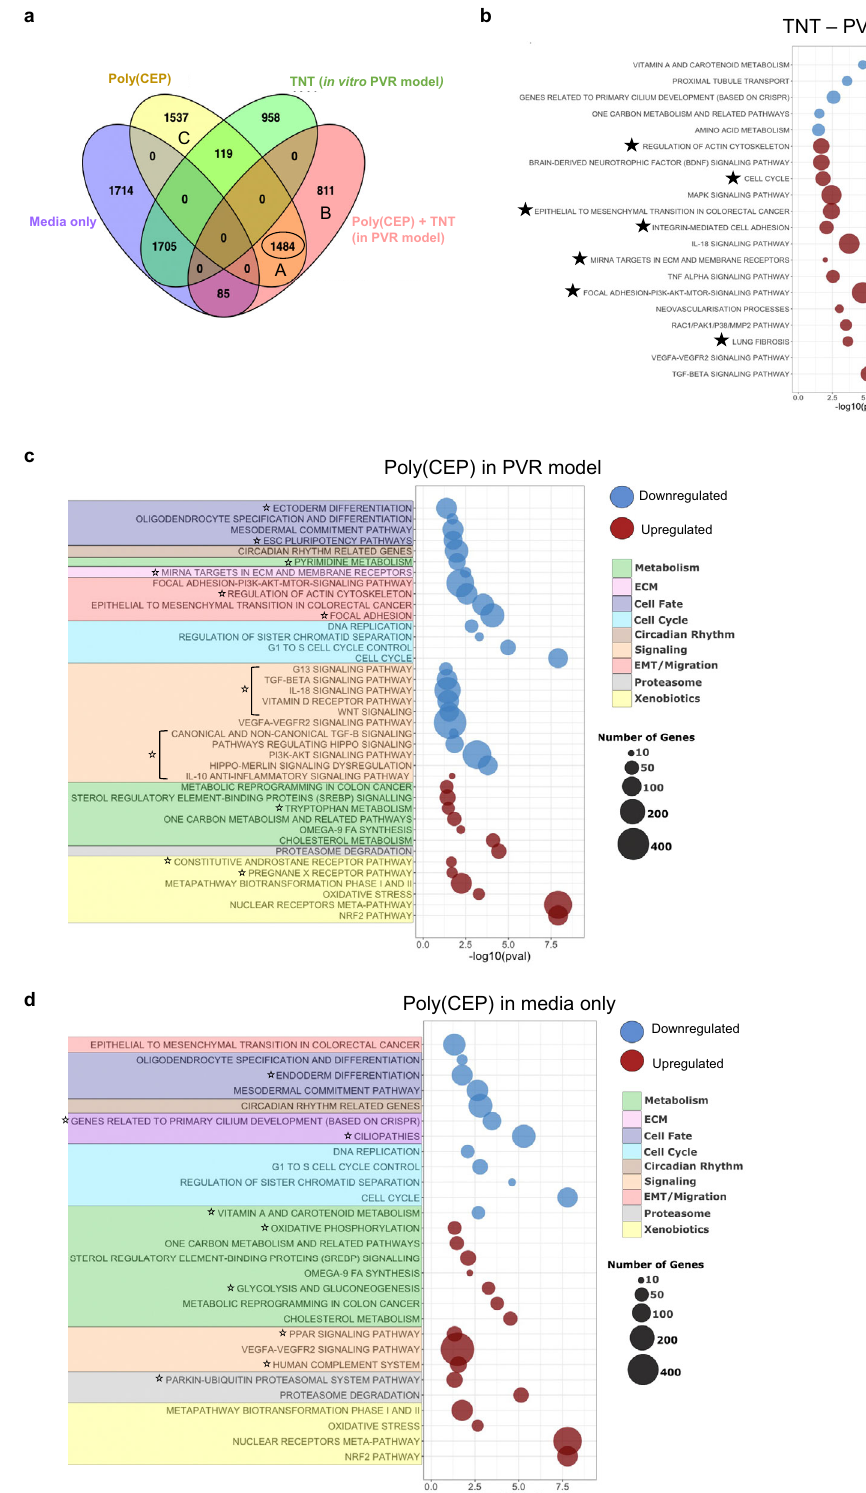
Fig. 5 Intracellular uptake of 1 wt% poly(CEP) induces global transcriptomic changes in RPE. a Venn diagram showing overlap of differentially expressed genes (Wald test, P adj < 0.05) identi fi ed by DESeq2 at 24 h post-exposure to media only, poly(CEP), TNT or poly(CEP) + TNT. 1484 genes are common in both poly(CEP) and poly(CEP) + TNT treated RPE cells. b Gene set enrichment analysis (GSEA) was performed on the in vitro PVR model induced by TNT at 24 h post-exposure and showed upregulation of classical pathways (Hollow black stars) with known involvement in PVR pathogenesis. c GSEA was performed for 1 wt% poly(CEP) + TNT (PVR model) 24 h post-exposure and showed downregulation of EMT, migration, and cellular proliferation pathways, but upregulation of pathways involved in xenobiotics, proteosome degradation, and metabolism, similar to d 1 wt% poly(CEP) in media only. Hollow black stars mark unique pathways between ( c , d